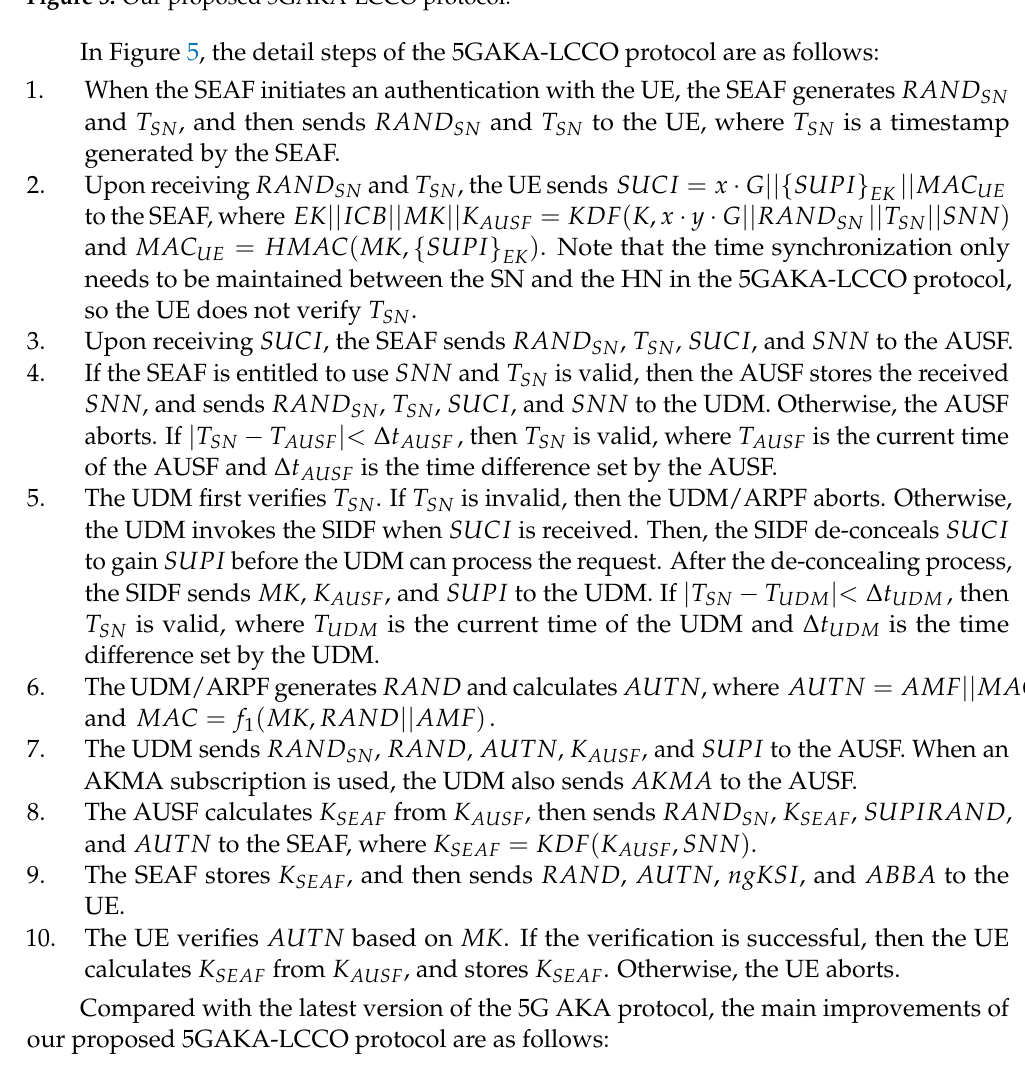
Figure 5. Our proposed 5GAKA-LCCO protocol.